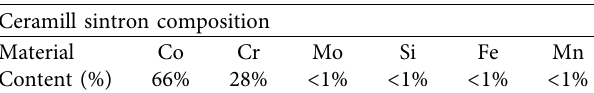
Figure 1: 3D Scanned images of prepared tooth using ceramill mind CAD software (Amann girrbach, Vorarlberg, Table 2: Composition of ceramill sintron CoCr (amann girrbach, vorarlberg, Austria) [29].